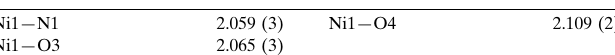
Selected bond lengths (A˚ ).